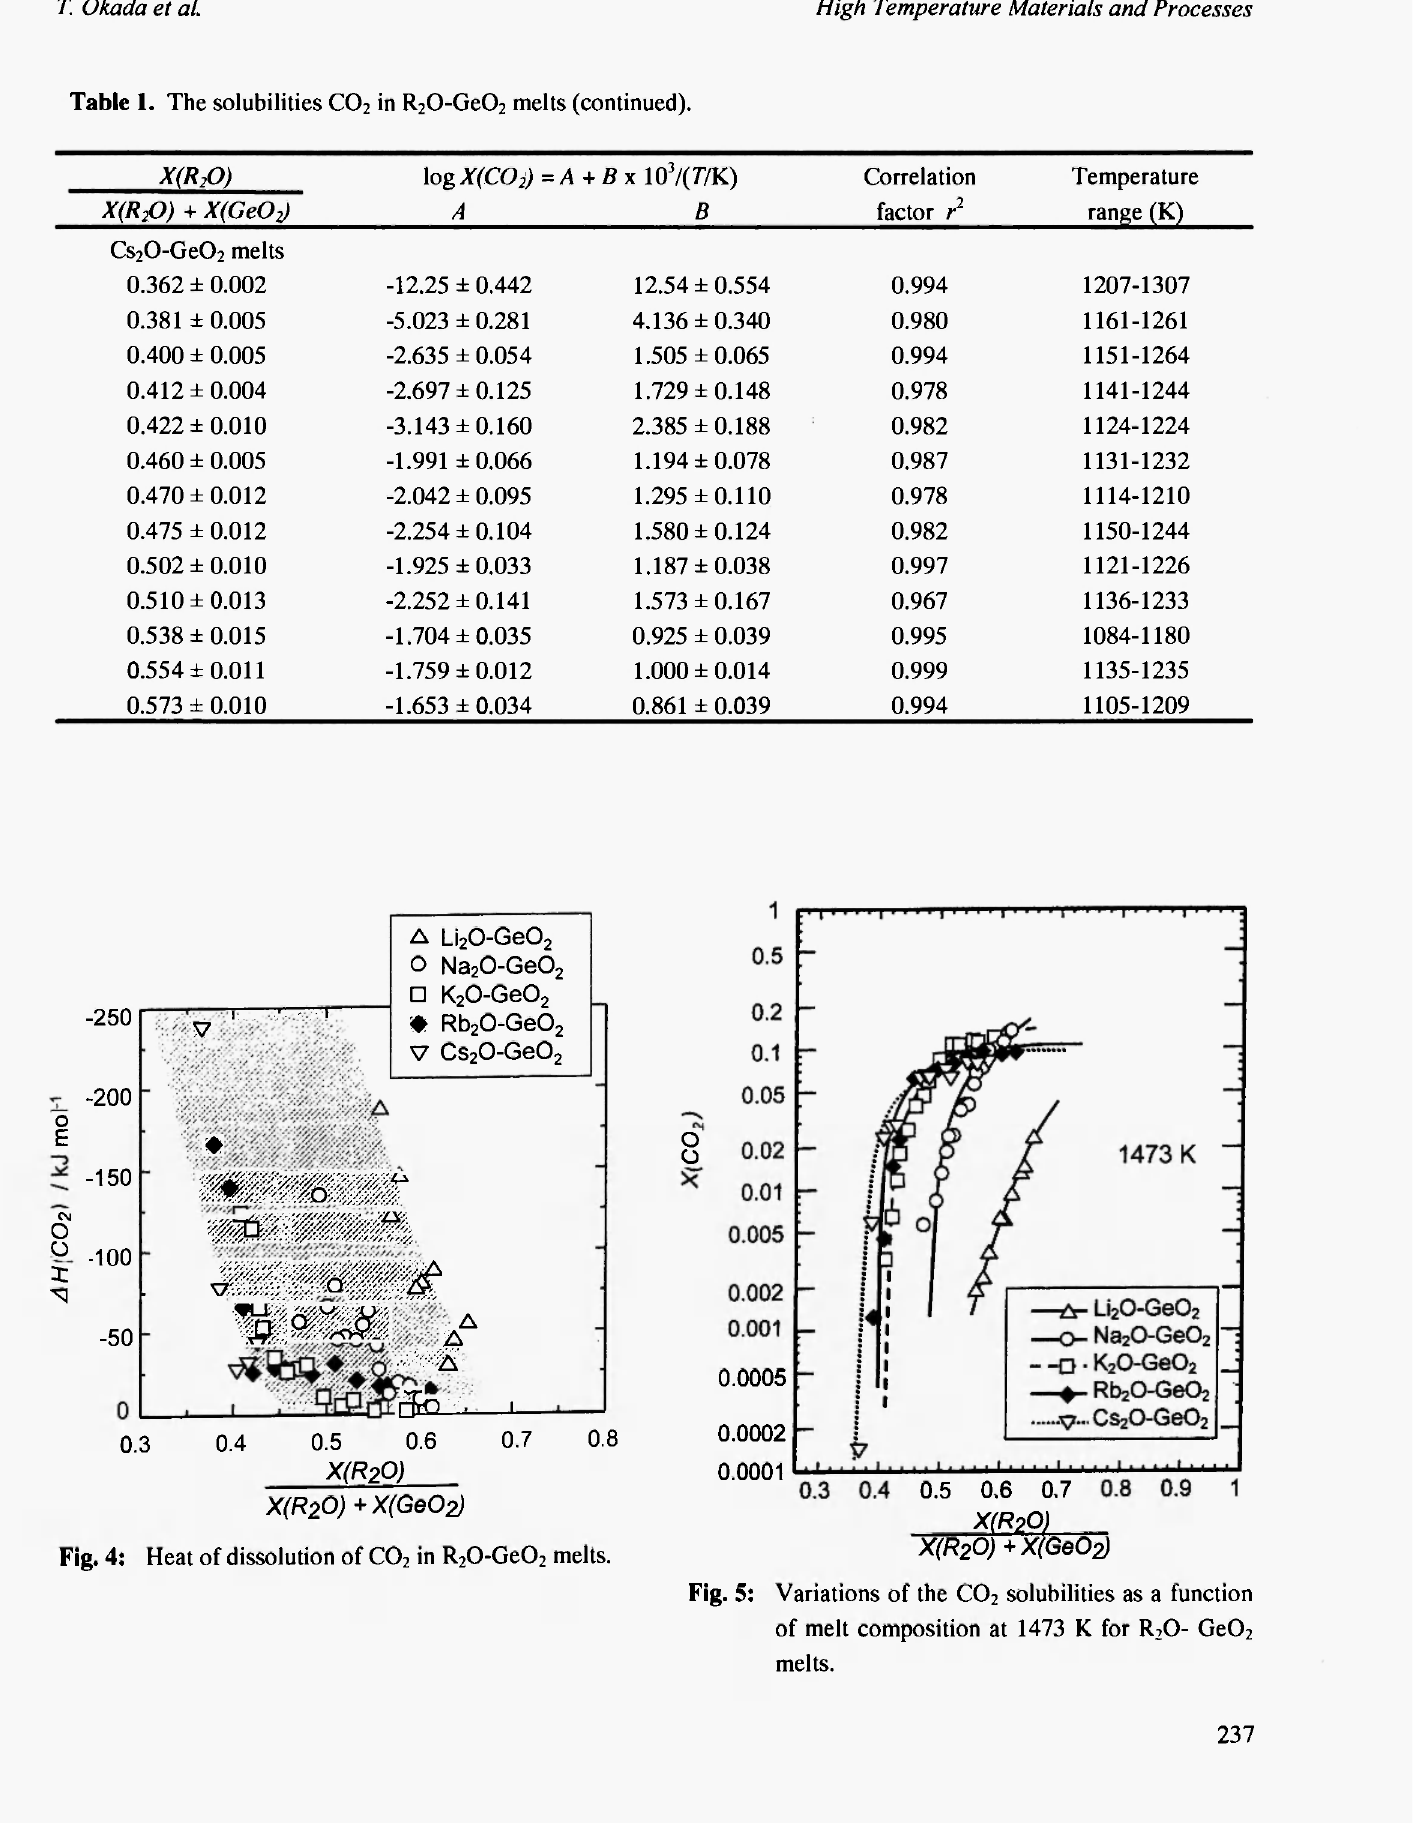
Fig. 5: Variations of the C0 2 solubilities as a function of melt composition at 1473 Κ for R 2 0- Ge0 2